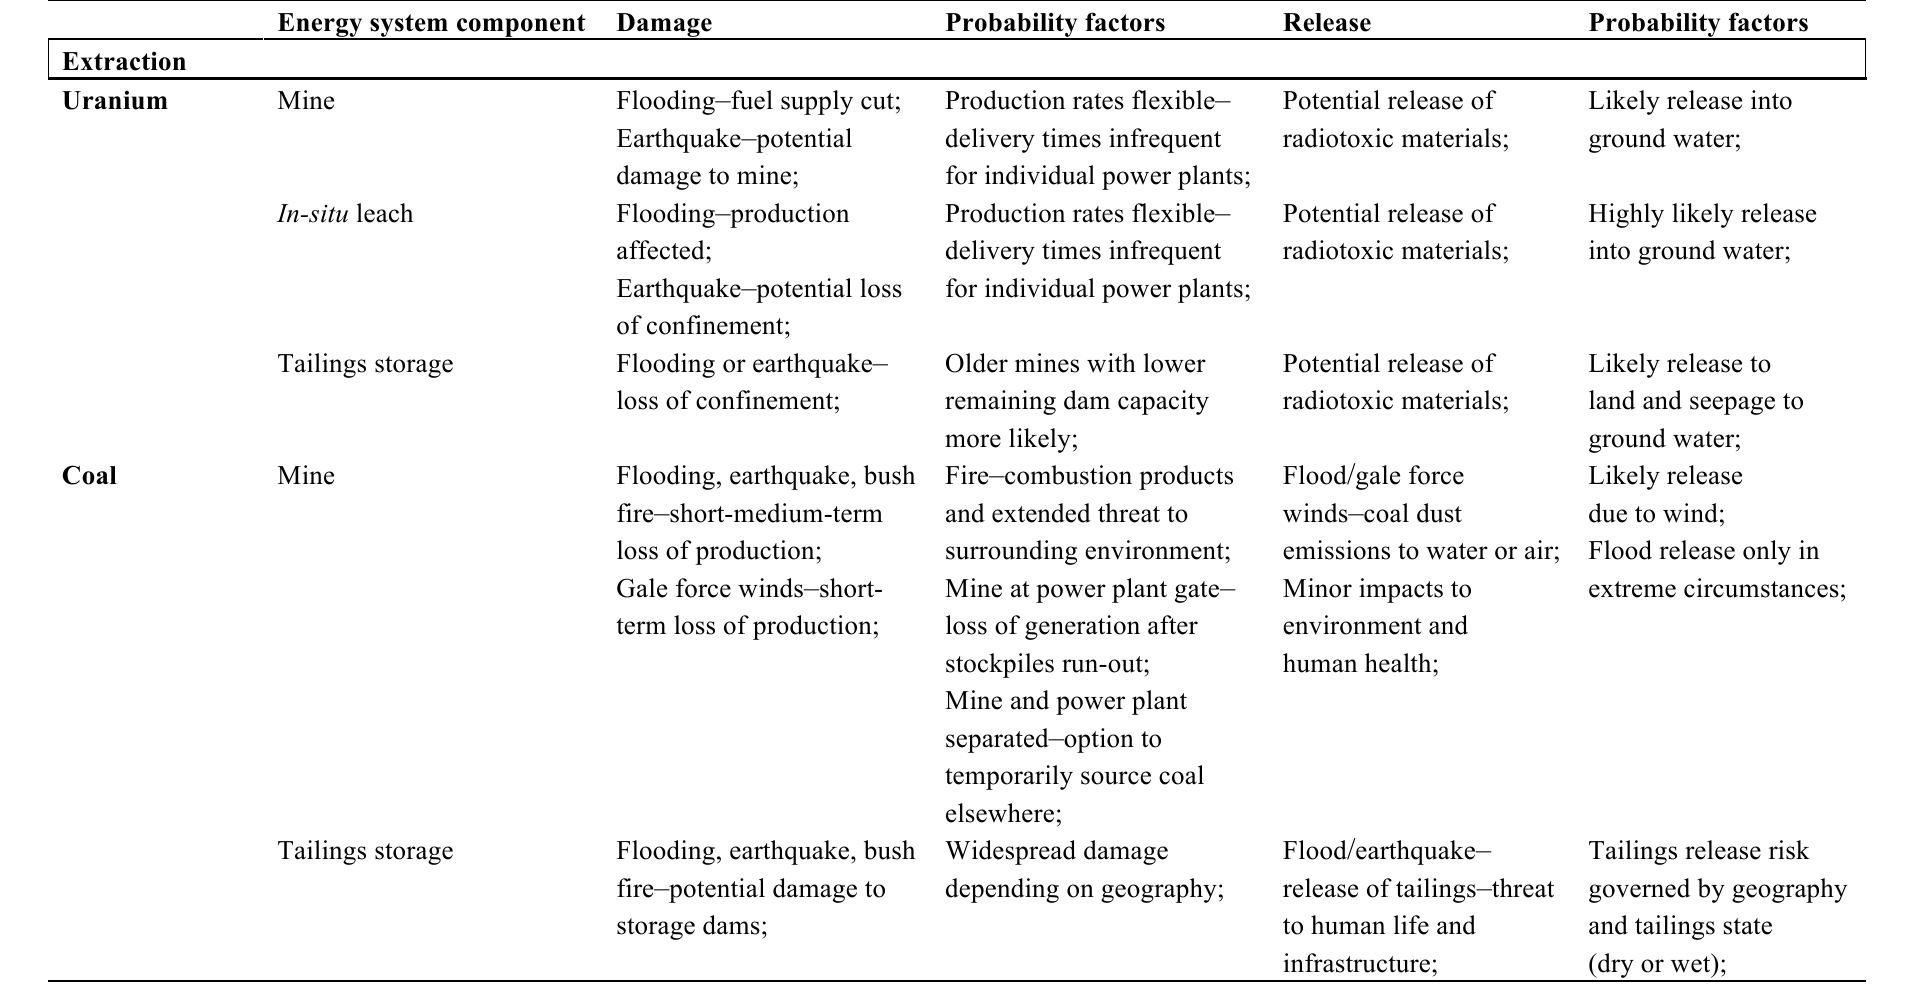
Table A4. Adapted-HAZOP assessment of risks associated with extraction and transportation stages (blank = not